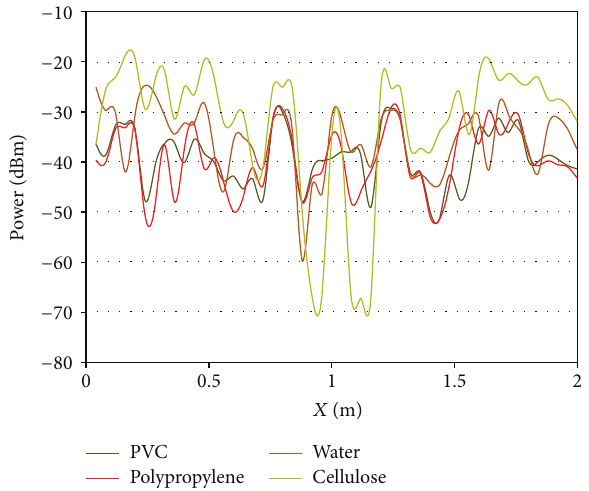
Figure 3: Radials of received power for different materials for the center of the first row of